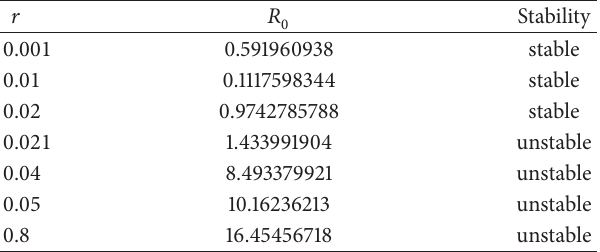
Table 3: Stability results of the fixed points 𝑋 ∗ 2 For different 𝑟